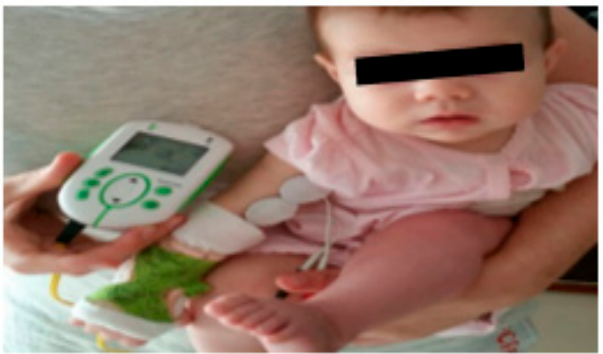
Figure 8. Electrical stimulation of the biceps and posterior splinting of the hand and wrist. Between 4 and 5 months of age, active loading was stimulated, in the prone position, with greater extension of the upper trunk and functional use of elbow extension/flexion and hand support.